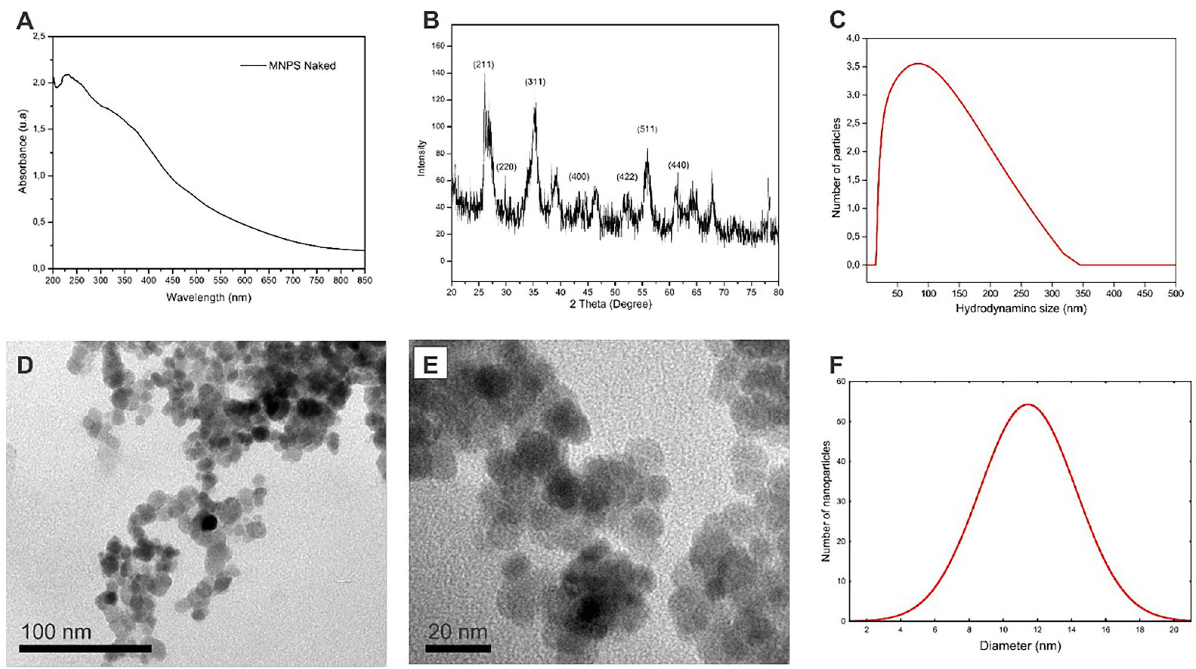
Figure 1. UV–Vis spectrum ( A ) and XRD of Fe 3 O 4 particles ( B ). Histogram obtained by DLS ( C ). Images of